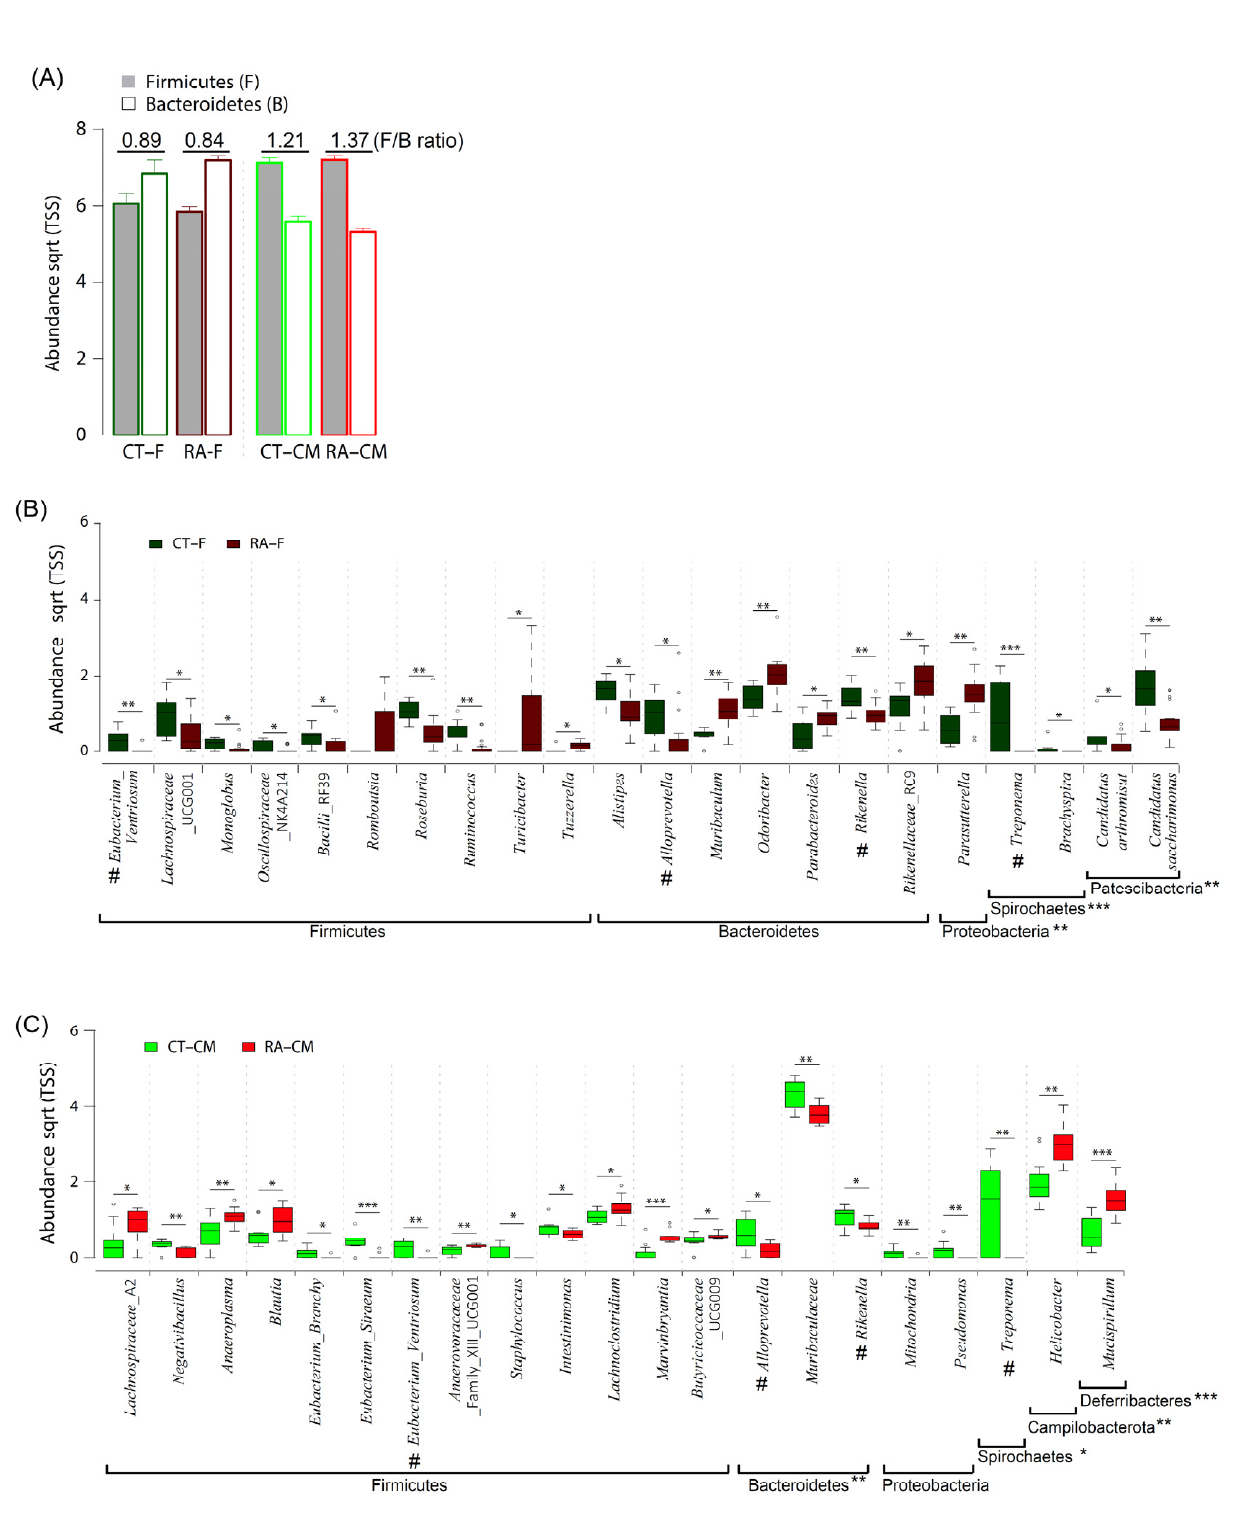
Figure 5. Composition of gut microbiome in healthy controls and RA mice. ( A ) The ratio of Firmicutes to Bacteroidetes in cecal mucus samples. ( B ) Significantly abundant genera in fecal samples. ( C ) Signif- icantly abundant genera in cecal samples. Data are median (horizontal line), interquartile range (box edges) and range (whiskers). * p < 0.05; ** p < 0.01; *** p < 0.001, Wilcoxon rank-sum test. The same genera between fecal samples and cecal mucus samples are indicated by